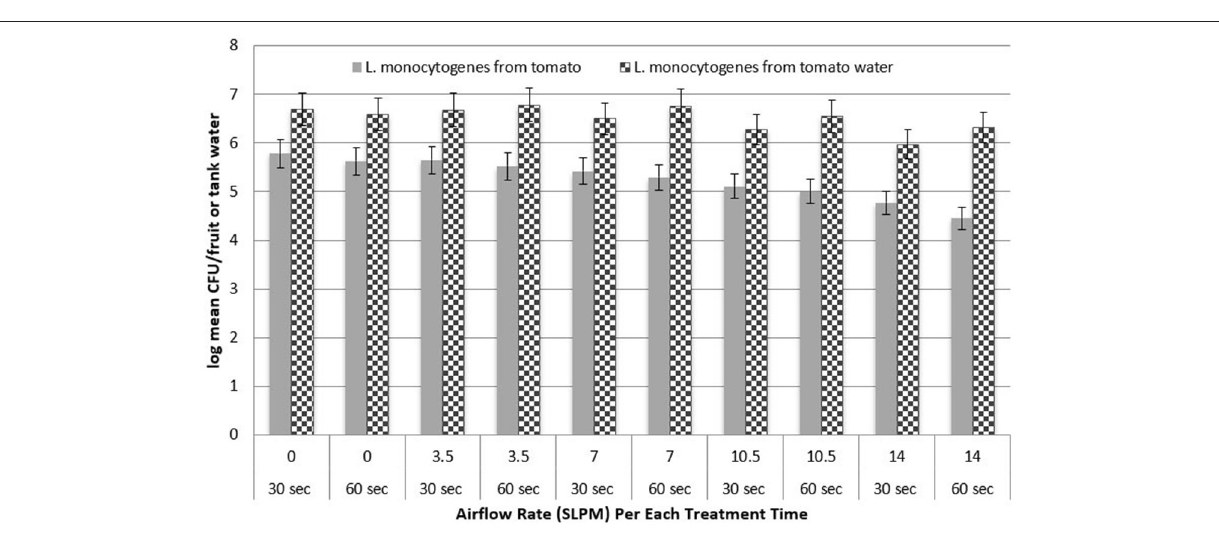
different when bubbles were applied for 30 vs. 60 s (data not